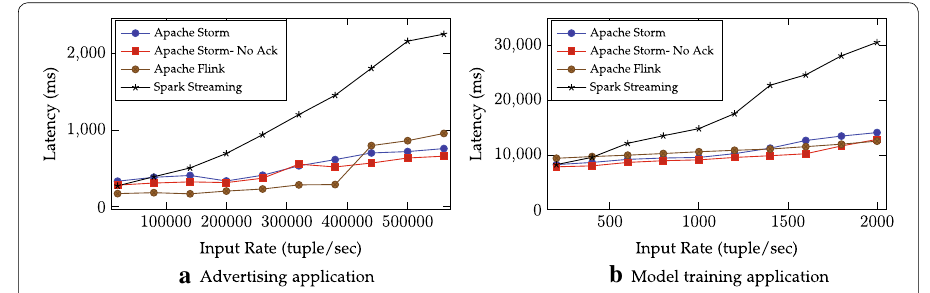
Fig. 16 99th percentile latency comparison over different rate